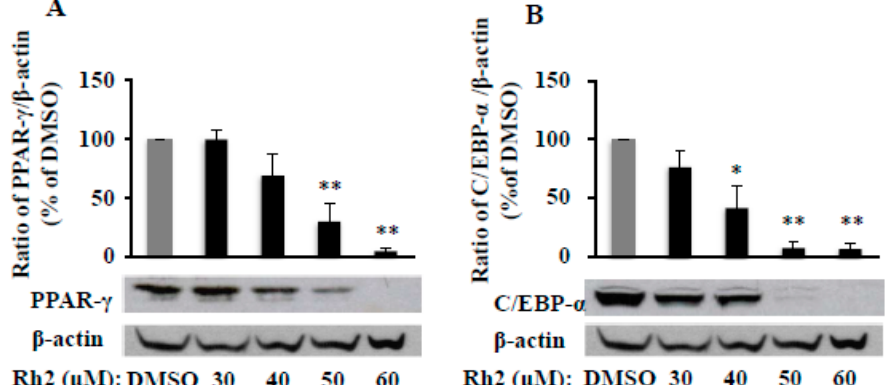
Figure 2. Ginsenoside Rh2 dose-dependently suppresses protein expressions of PPAR- γ ( A ) and CCAAT / enhancer binding protein (C / EBP)- α ( B ) in 3T3-L1 cells. On day 7, cells treated with various concentrations of Rh2 were collected to measure peroxisome proliferator-activated receptor gamma (PPAR- γ ) and C / EBP- α protein expressions by Western blotting and normalized by β -actin expression. Values are means ± SE, n = 3. A set of representative images and bar graphs are shown. * p < 0.05, ** p < 0.01 vs. DMSO.